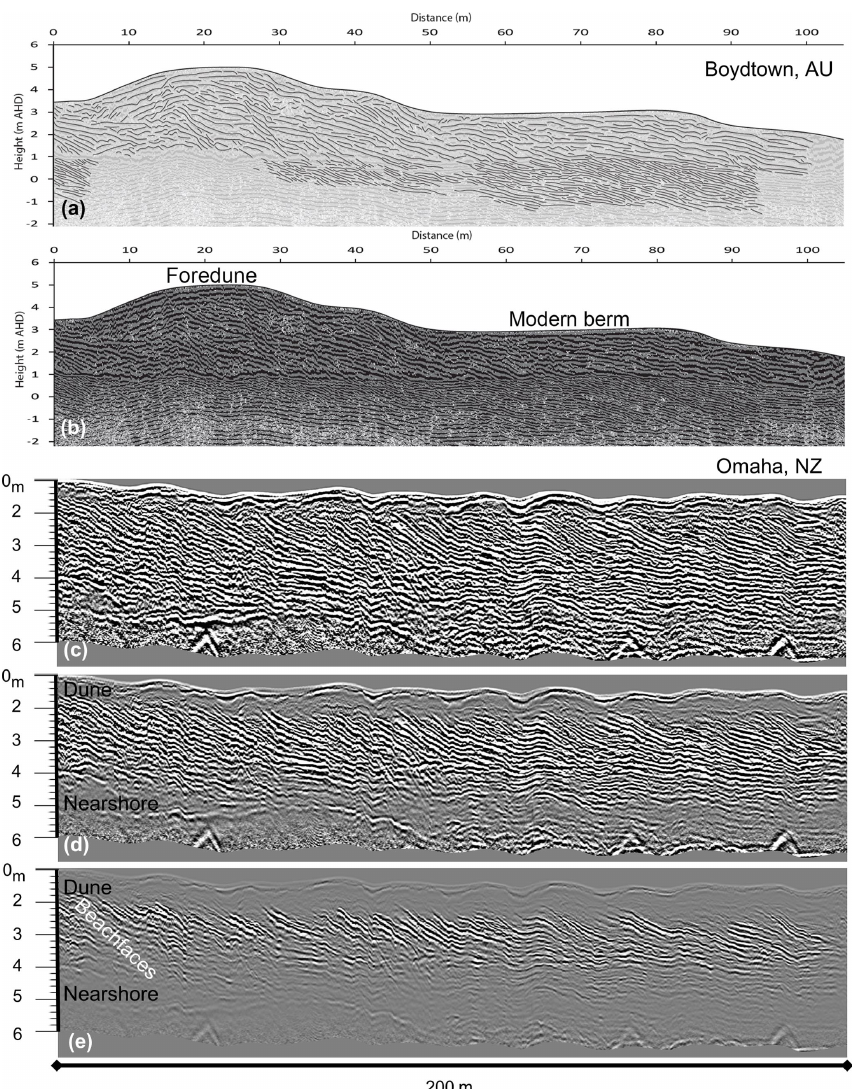
Figure 7. (a) An example of the “interpreted” GPR data presented in Oliver et al. (2017b). (b) An example of uninterpreted, processed GPR data from the Oliver et al. (2017b) supplementary material showing the high gain applied. Note that in both presentations of GPR data, it is hard to distinguish dune from beach facies, let alone differentiate storm-eroded paleo-beachfaces from the swell-accreted berm stratigraphy. (c) GPR data from a prograded barrier in New Zealand (Dougherty, 2014) with a similar high gain applied. (d) The same GPR data as in (c) but with the gain adjusted so that the more homogenous dune sand is accurately represented as a low-amplitude signal compared to the alternating layers associated with paleo-beachfaces deposited under varying wave energies. (e) The same GPR as in (c) – (d) , but with the gain control decreased such that the strongest reflections are highlighted. Once these reflections are ground-truthed as high-energy lag deposits, these data can be used to construct a storm record. Figure modified from Oliver et al. (2017b) and Dougherty